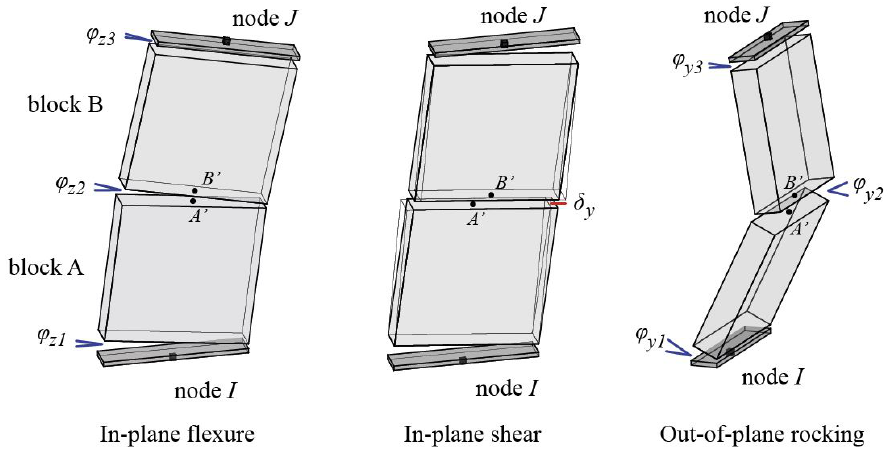
Figure 2. Macro-element by Vanin et al. [38]: deformation